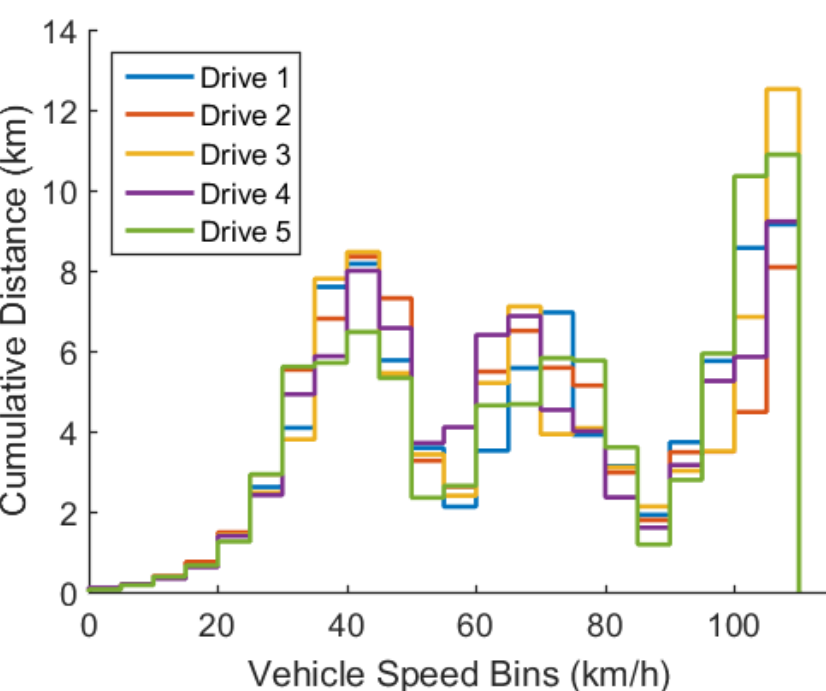
Figure 8. Vehicle speed residency across each drive with respect to distance traveled.